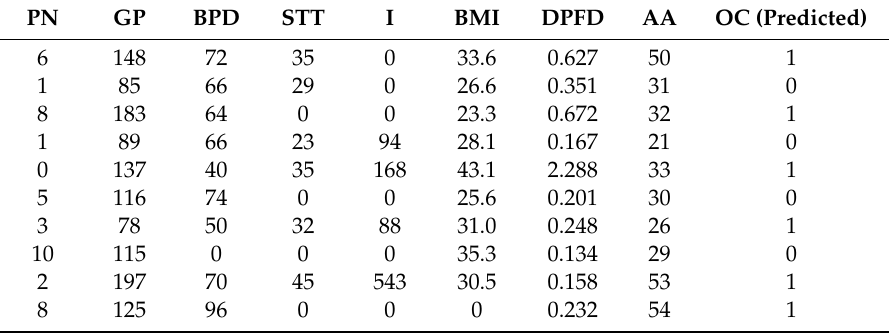
Table 2. Example of predicted outcomes (diabetes prediction): OC is the labeled class.